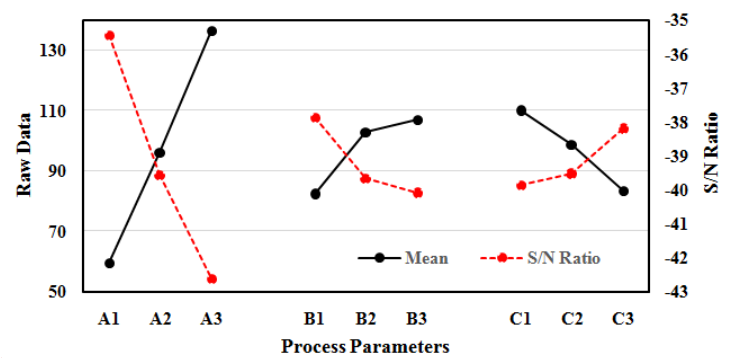
Figure 4. Raw data and S/N ratio plot for